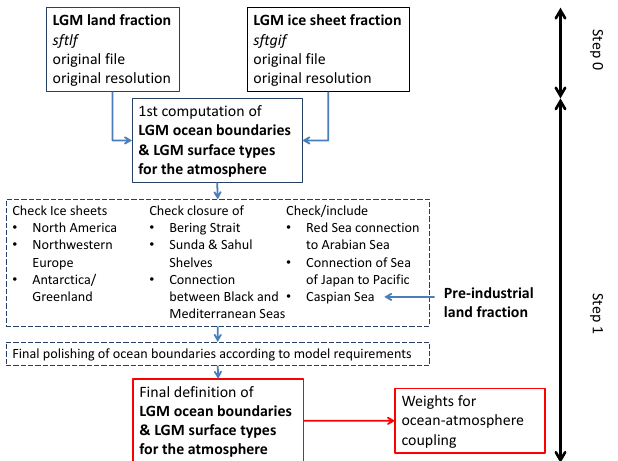
Figure 3. Summary of steps to be followed for the definition of the basic surface types for the atmosphere and ocean